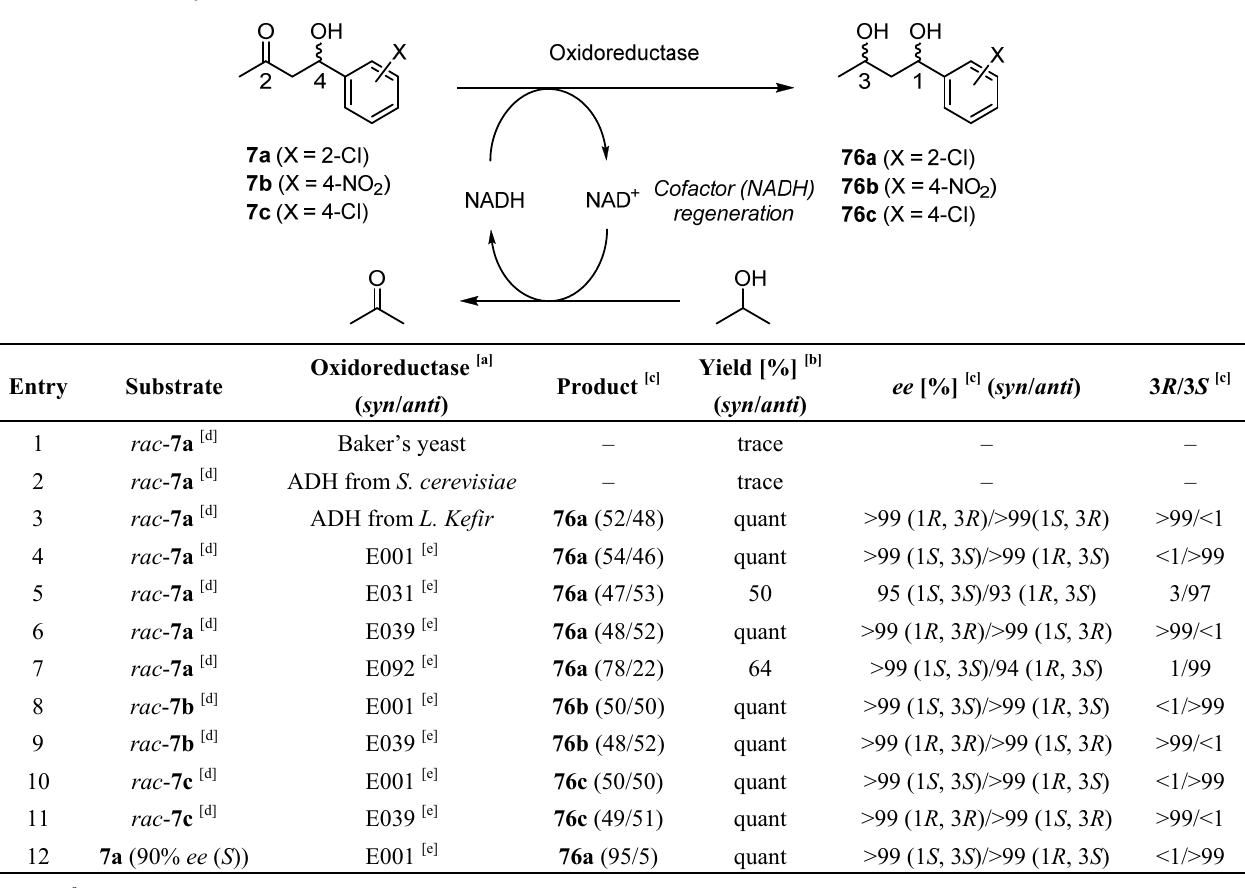
Table 9. Results for the asymmetric reduction of β -hydroxyketones 7a – c catalyzed by for one